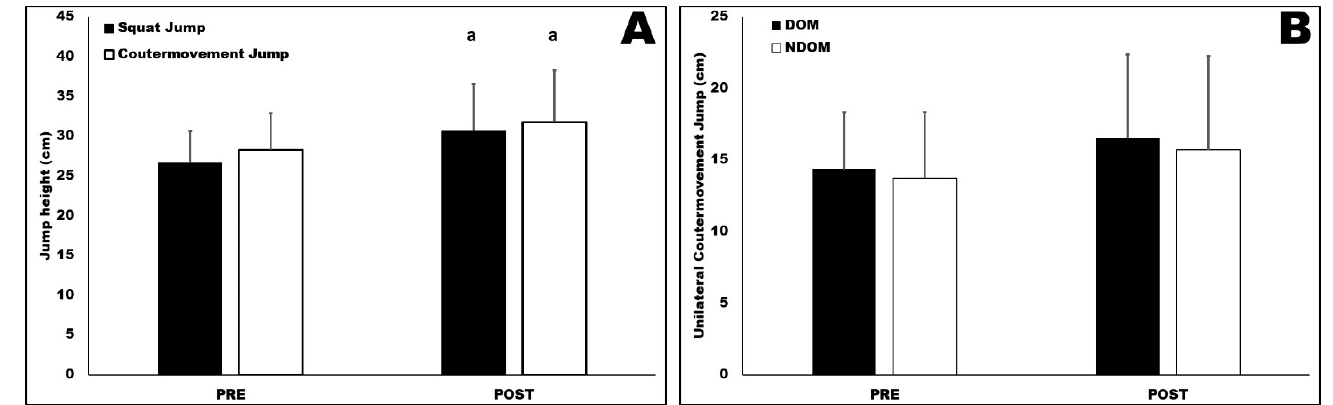
Figure 1. Jump height of bilateral squat jump and countermovement jump performances ( A ) and unilateral countermovement jump performance at the start (PRE) and after 15 weeks of a competitive period (POST) ( B ). DOM = dominant leg; NDOM = nondominant leg; a = different than PRE ( p < 0.05); bilateral squat jump and countermovement jump were not compared.